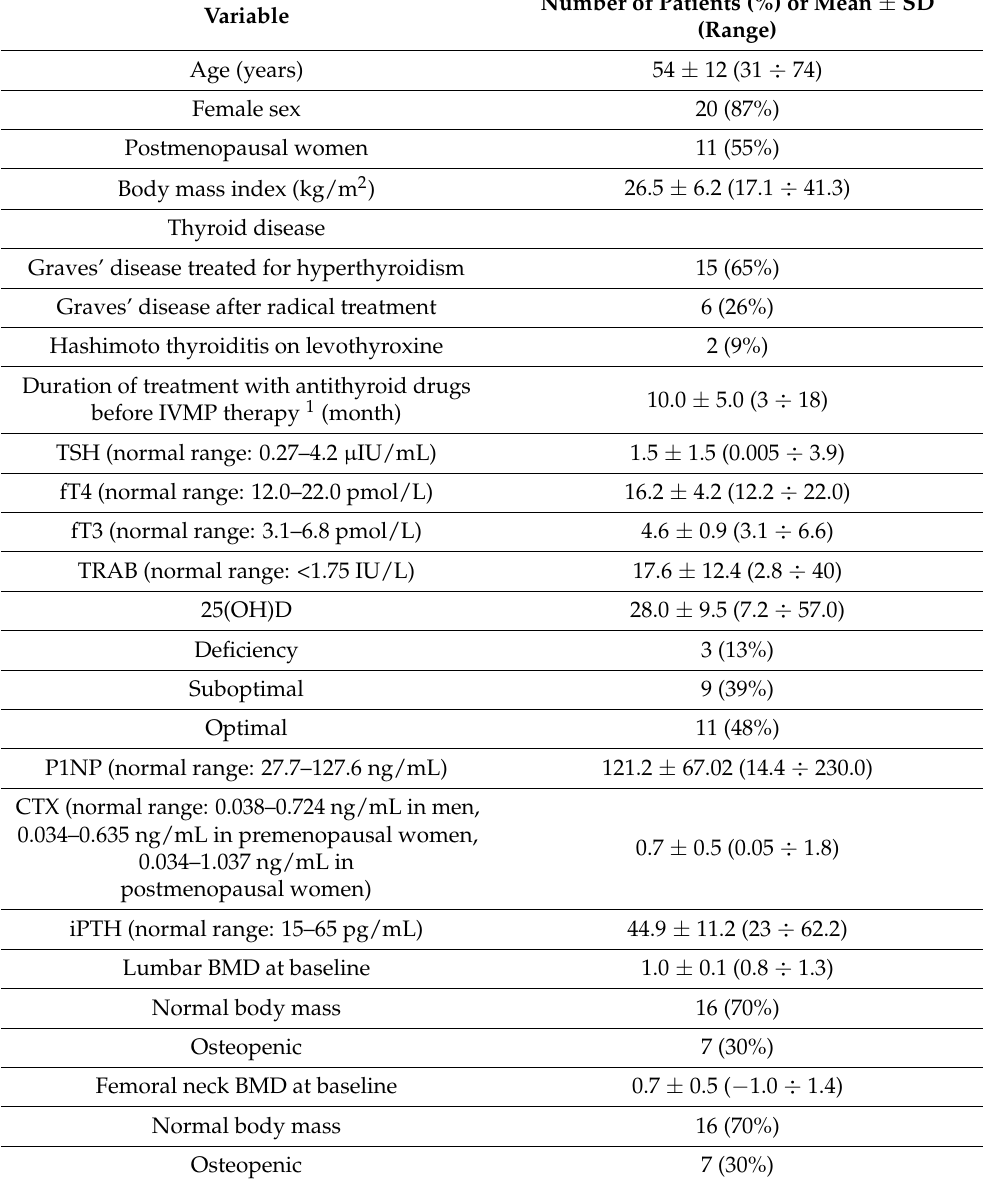
Table 1. Baseline characteristics of patients ( n =